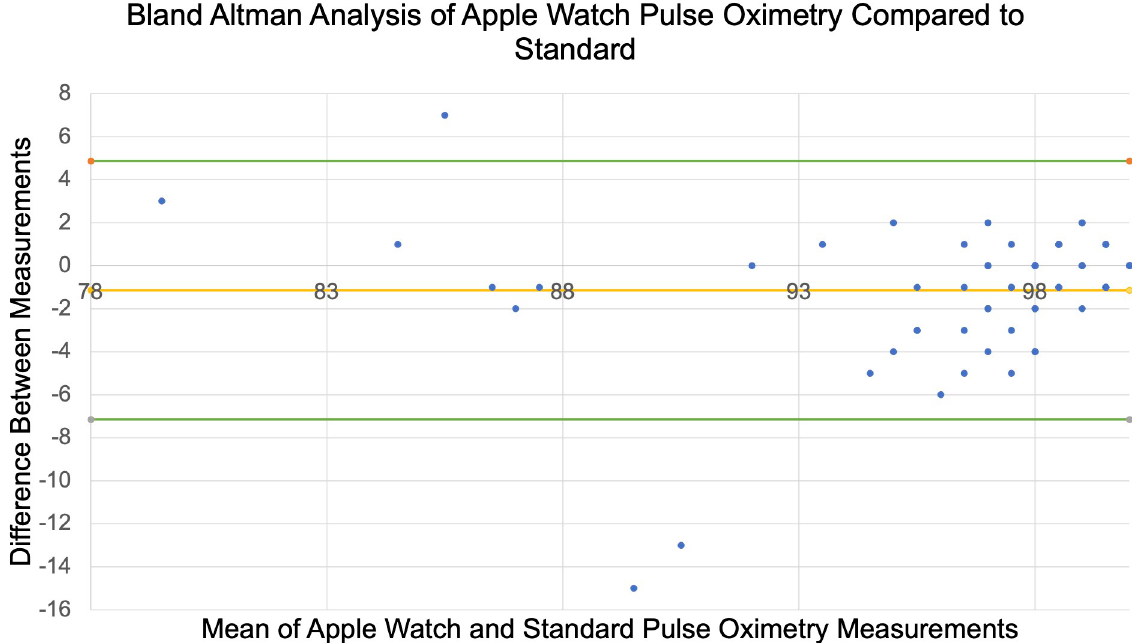
Fig 2. Bland Altman Analysis of AW6 pulse oximetry compared to standard. Horizontal lines represent the mean difference of oxygen saturation between the Apple Watch 6 and standard pulse oximetry and the upper and lower limits of agreement (LOA). Upper and lower LOA represent +1.96 and -1.96 standard deviations respectively. Points may represent multiple